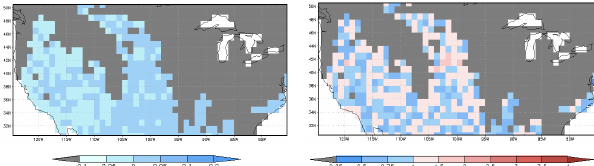
Fig. 5. Mean (left column) and variance (right column) of normalized innovations (dimensionless) of data assimilation diagnostics. The gray color represents grid cells excluded from the computa-